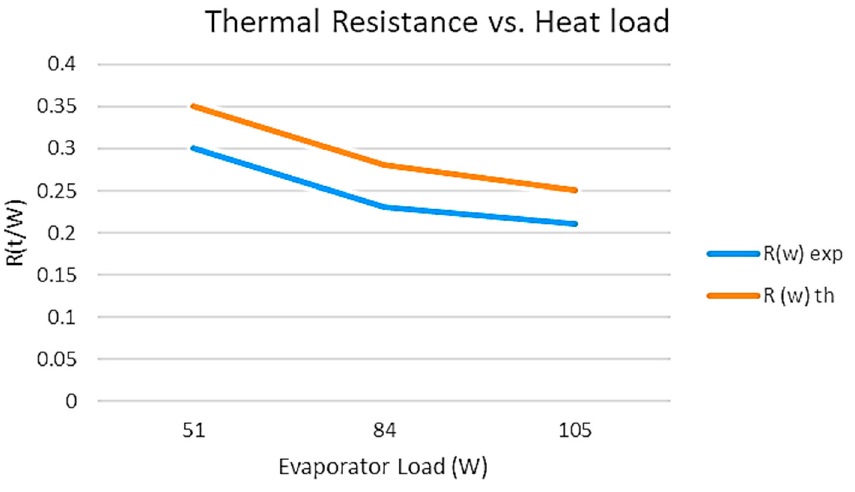
Figure 26. Comparison between present model and data for nanofluid Fe 3 O 4 data with different heat loads in the evaporator section of heat pipe [54].